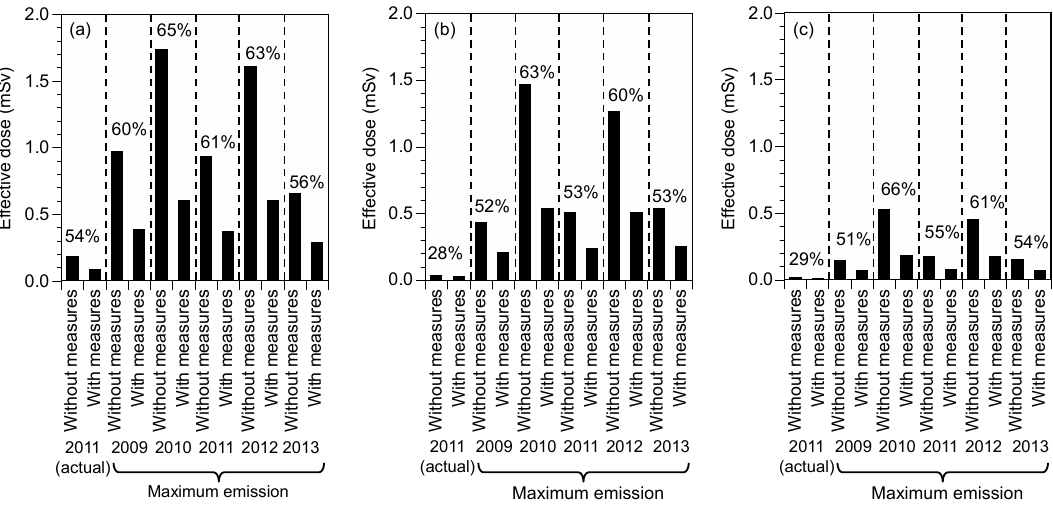
Figure 1. Effective doses for men ( ≥ 19 year) in the first year and the effectiveness of measures under different climate conditions without and with measures (Case 1): ( a ) Fukushima City, ( b ) Tokyo, and ( c ) Osaka. Percentages represent reduction ratios. Measures include restrictions on food distribution and evacuation.